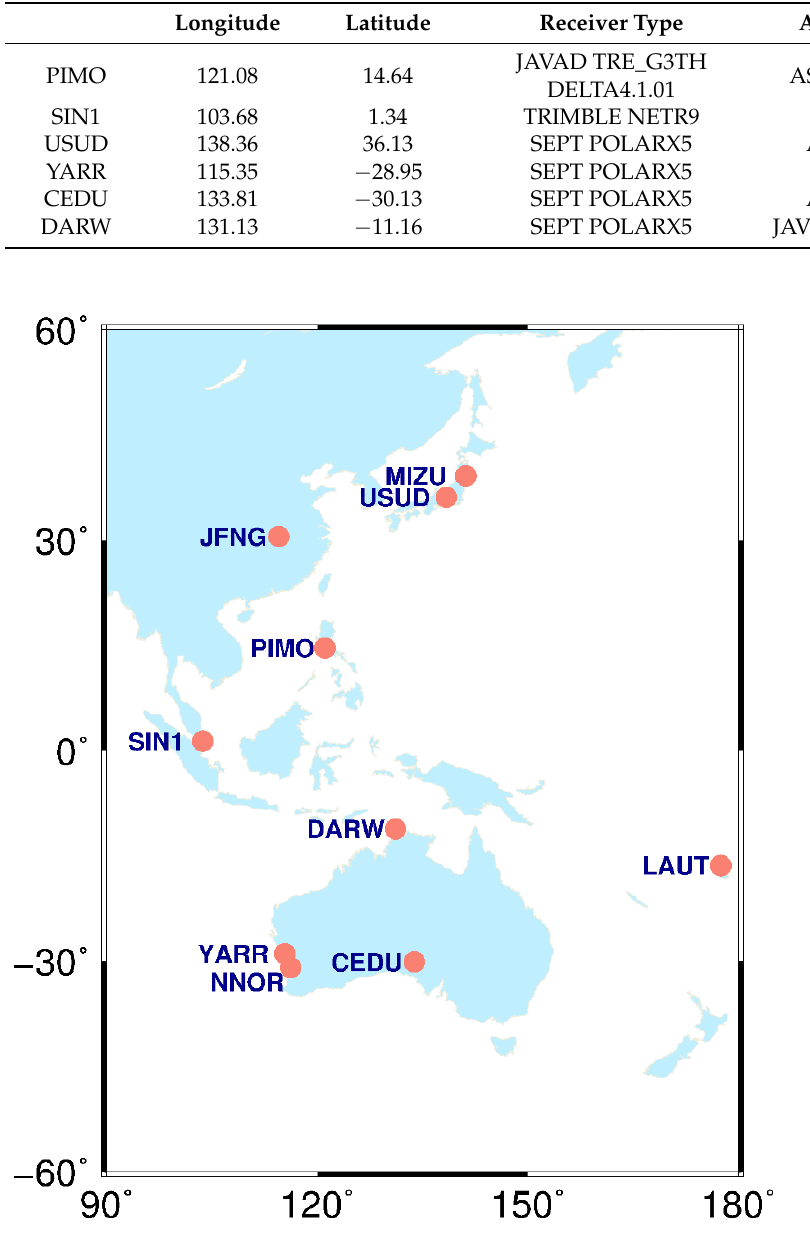
Figure 1. Distribution of selected stations.